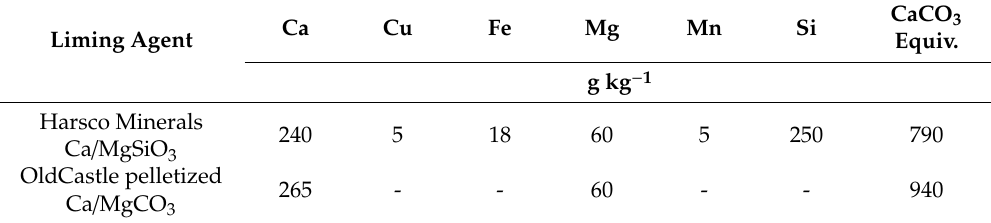
Figure 1. Pull-behind wear simulator applying wear treatment to creeping bentgrass fairway main plots, August 2011. plots, August 2011. Table 1. Guaranteed analysis of granular liming agents (per manufacturers’